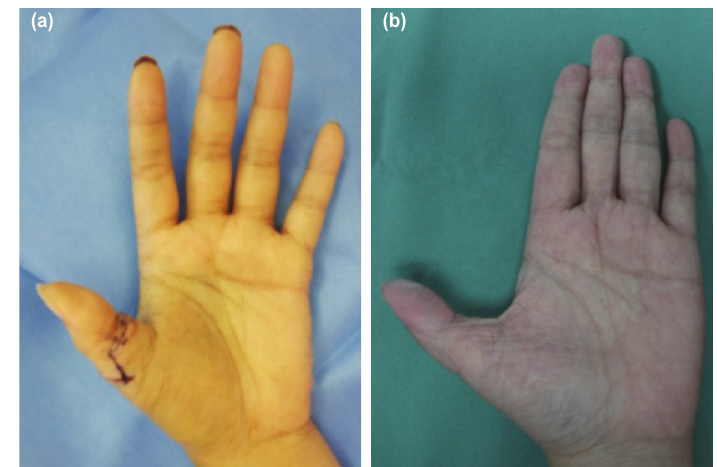
Post-replantation at (a) two weeks and (b) one year follow-up. Fig. 3: